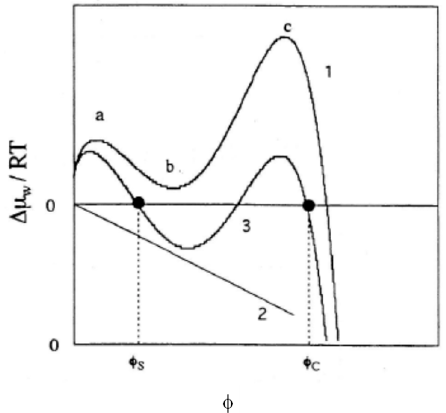
Figure 1. Calculated swelling curves in terms of Equation (11) in the case of the charge-induced volume phase transition. ( ν V 1 / V 0 ) = 0.0058. χ 1 = 0.356 and χ 2 = 0.840. Curve 1 ( i = 0) shows two maxima a and c and one minimum b. Line 2 represents the last term of Equation (11) with i = 0.22. Two black dots in Curve 3 ( i = 0.22) represent the volume fractions of the condensed ( φ C ) and the swollen ( φ S ) states in equilibrium with each other.